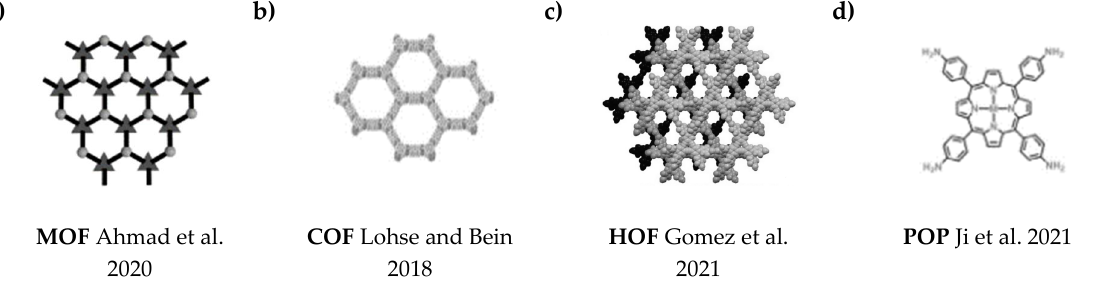
Figure 3. The structures of porous materials: ( a ) MOF [125], ( b ) COF [126], ( c ) HOF [127], ( d ) POP [110].